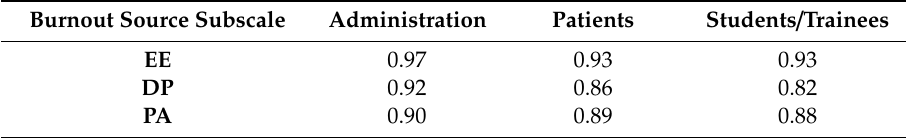
Table 4. Internal Consistency (Cronbach’s alpha Values).